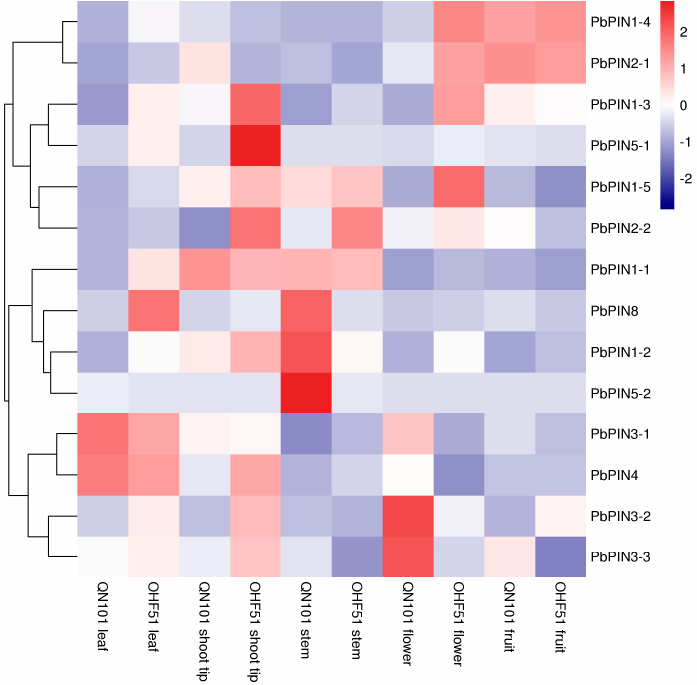
Figure 5. Heat map of the expression level of 14 PbPINs in different organs. The tissues used for the expression profiling are indicated at the bottom of each column. A cluster dendrogram is shown on the left. PINs are divided into four major groups based on their expression. The color key at the top right corner represents the Z-score values transformed from log2-based expression values obtained by qRT-PCR.